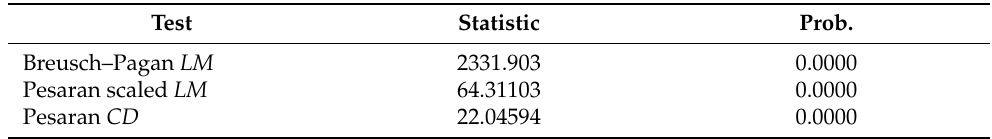
Table 1. Cross-sectional dependence test results. Test Statistic